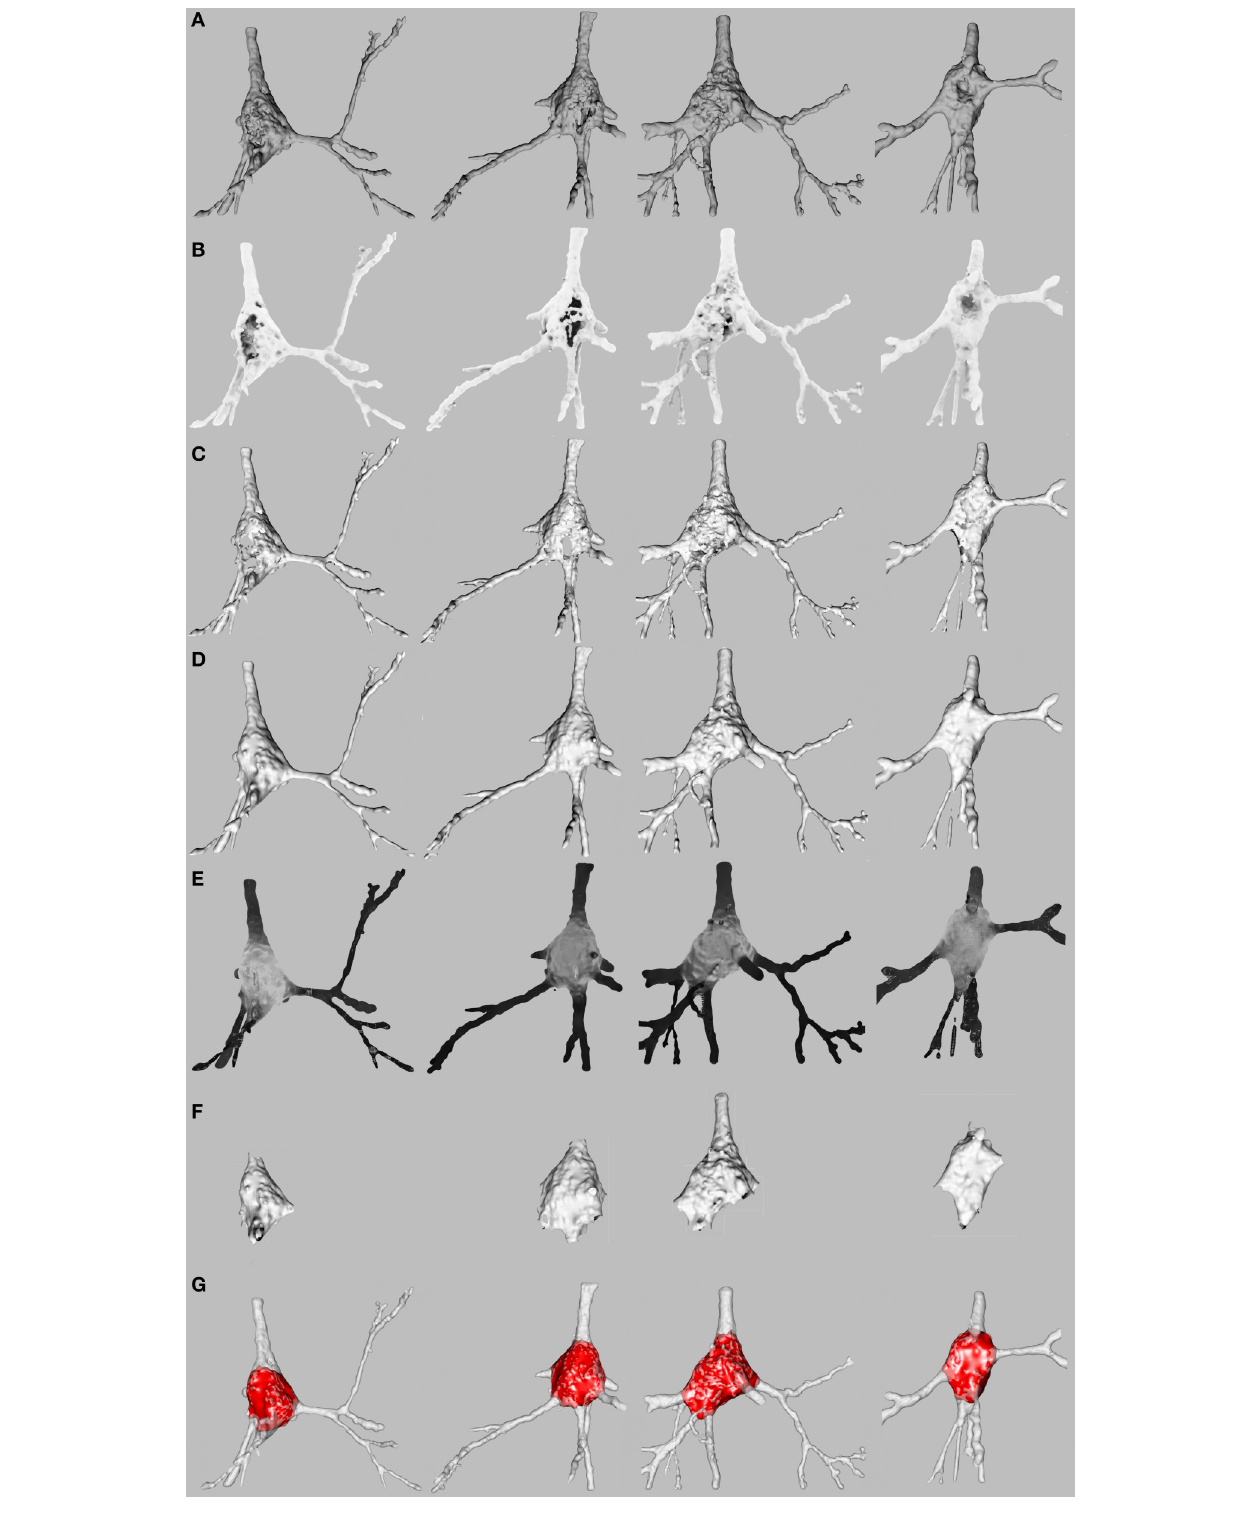
FIGURE 2 | Repair and segmentation process. (A) Initial state of four representative pyramidal cells. (B) Neuron exposure to ambient lightning. (C) Neuron after vertices forming holes and cavities or positioned inside the mesh have been discarded. (D) Neuron after mesh closing. (E) Vertices of the mesh colored according to shape diameter function to segment soma and dendrites. (F) Neuron after the basal dendrites have been removed. (G) Final result.